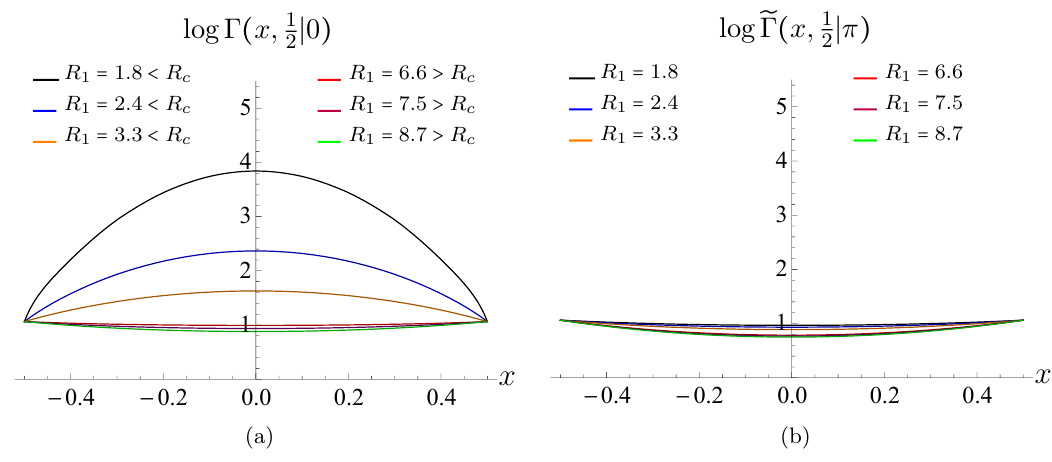
Figure 9 . Dependence of the Bethe-Salpeter wavefunction on x at (cid:12)xed y . The parameters are the same as in (cid:12)gure 7: (a) in the ladder phase ( x ) in (3.30) has a clearly pronounced pro(cid:12)le, while in the rainbow phase the dependence on x is almost (cid:13)at (b) The dependence on x is much weaker for loops of the same